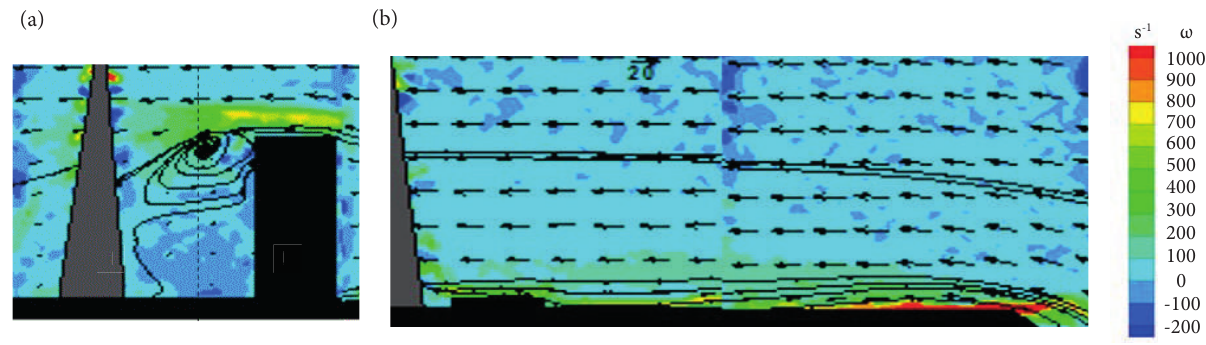
Figure 17. Vorticity contours and velocity vectors – β = 45°, α = 0° and Re = 4.3 × 10 5 .